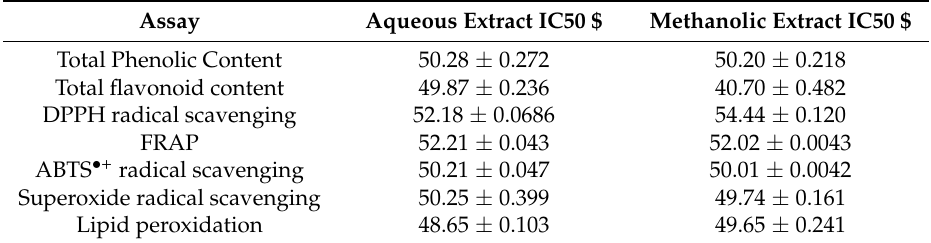
Table 1. IC 50 values for in vitro antioxidant assays. $ Unit of IC 50 of all activities is mg of equivalents/g powder. Each value represents mean ± SD. ( n =